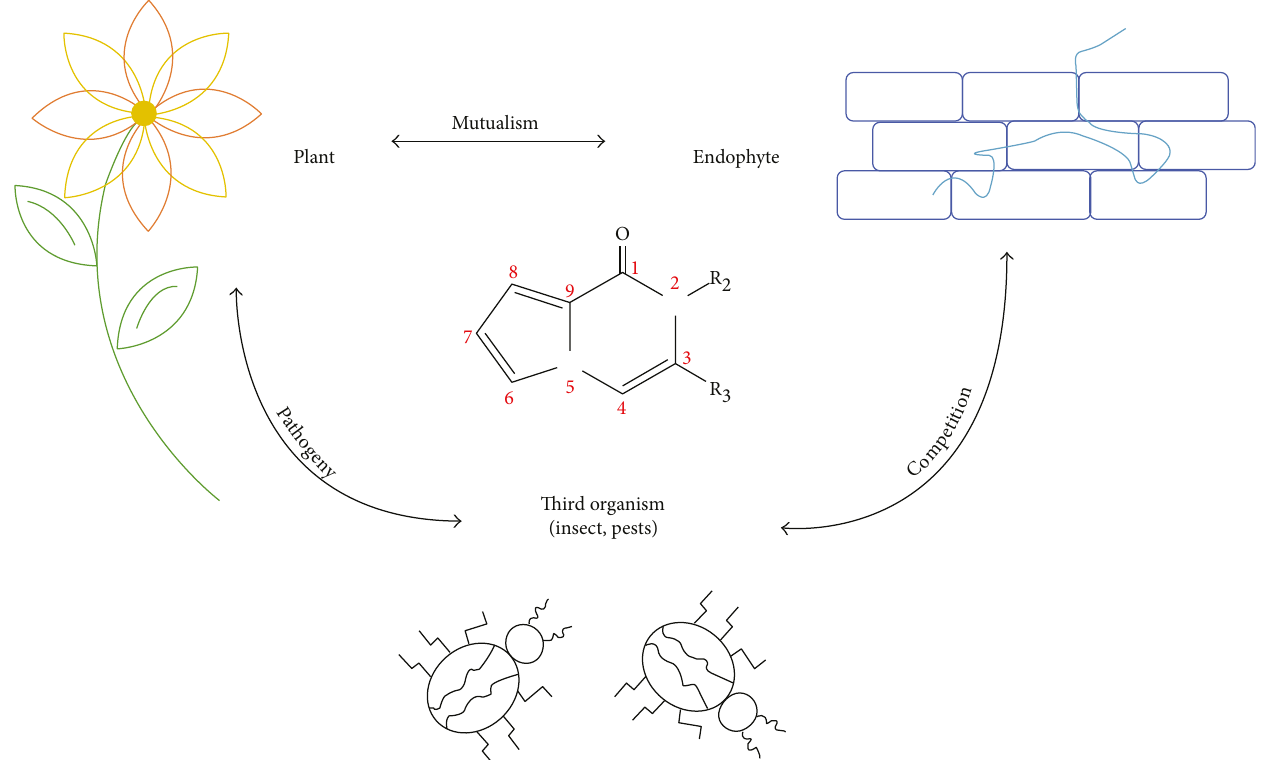
Scheme 2: Schematic representation of the endophyte-infected